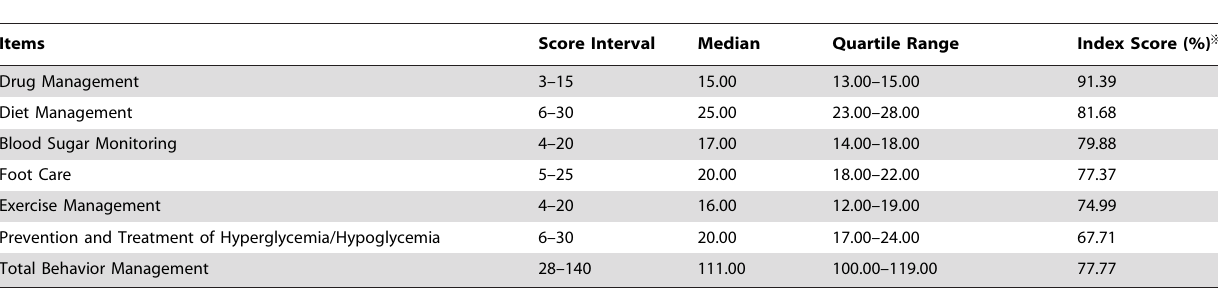
Table 1. Scores of T2DM self-management behavior for each dimension (N =364).